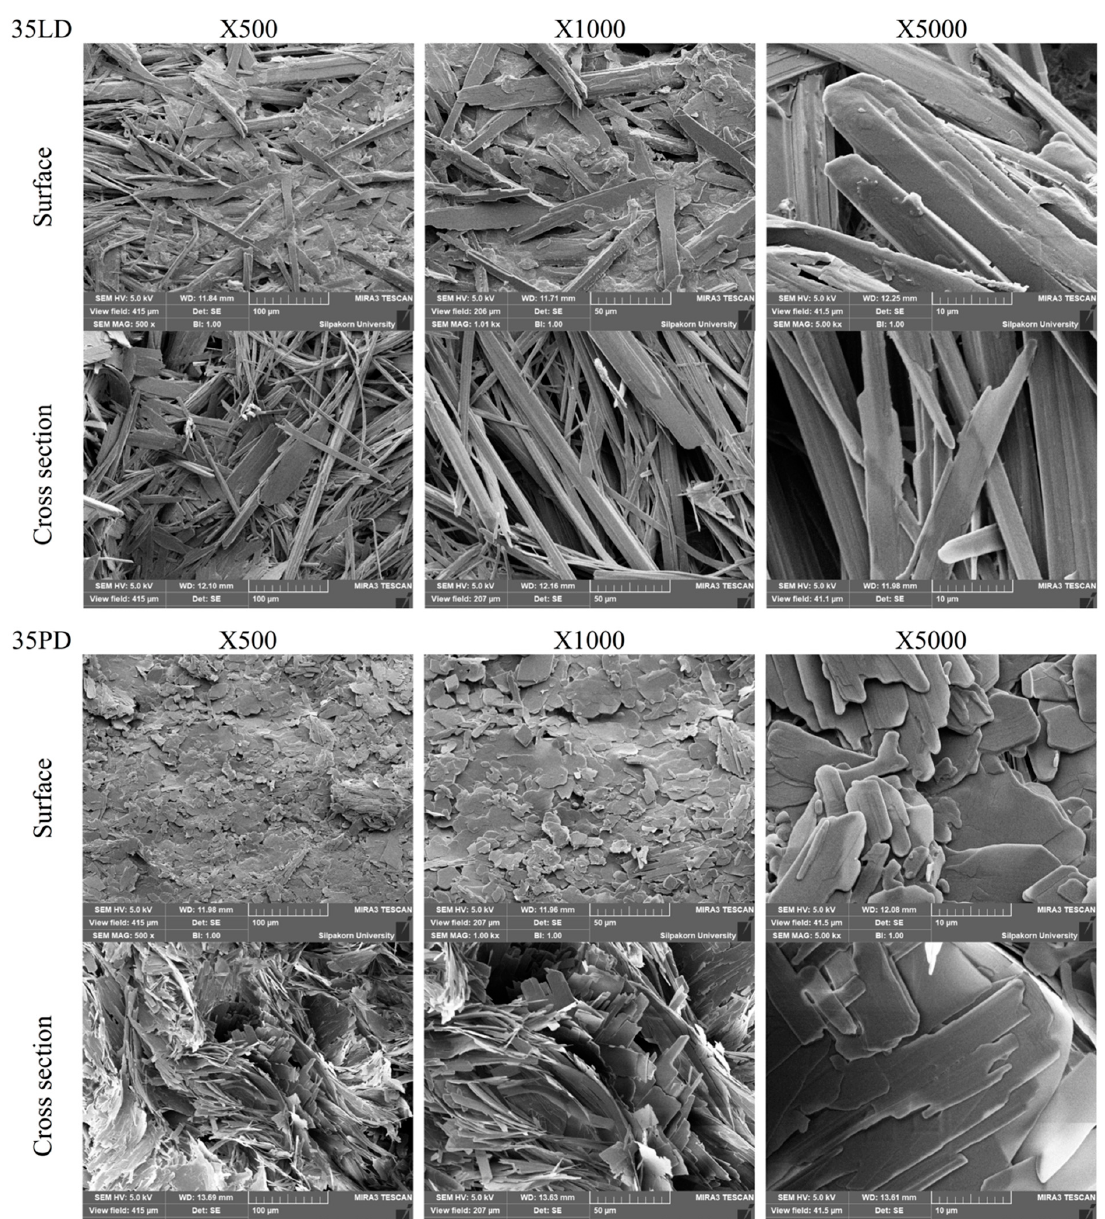
Figure 8. Topography under scanning electron microscope of formed matrix after release test.